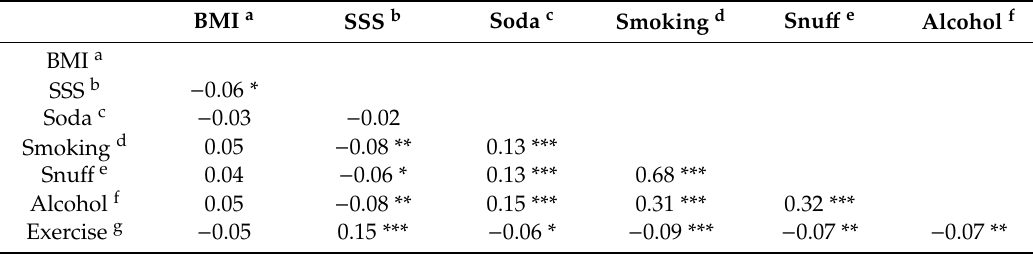
Table 3. Spearman’s correlation coe ffi cient (rho) for the included variables in the SEM for the 2017 survey, n = 1534. BMI a SSS b Soda c Smoking d Snu ff e Alcohol f BMI a SSS